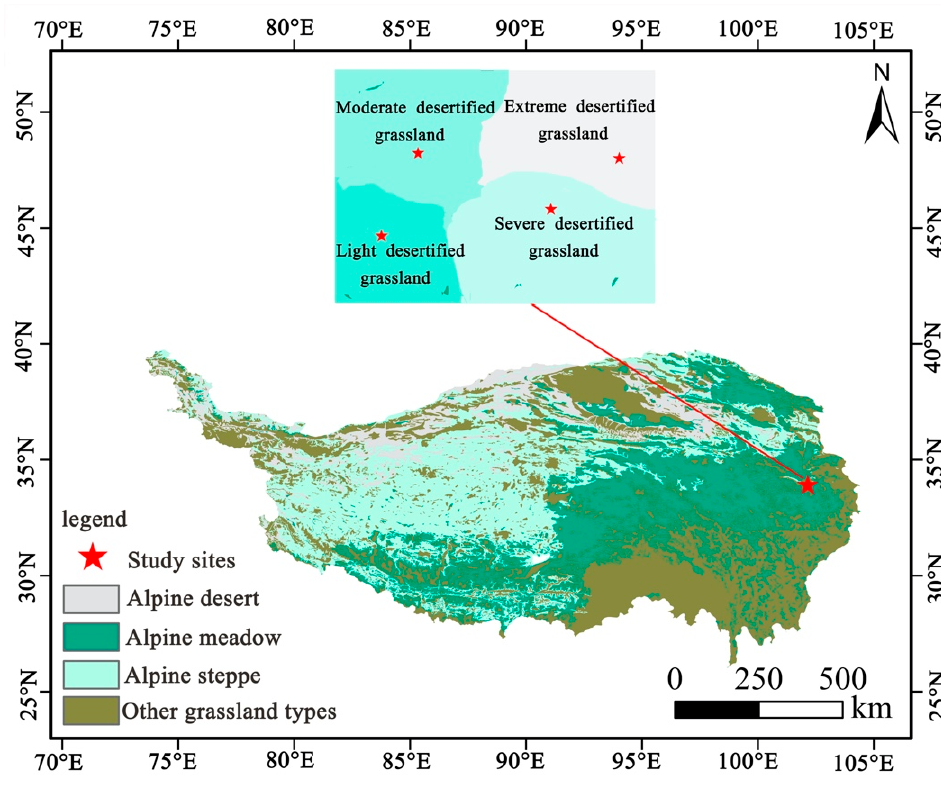
Figure 1. Distribution of study sites on the Tibetan Plateau. Table 1. Classification and characteristics of desertified grasslands. Community Type